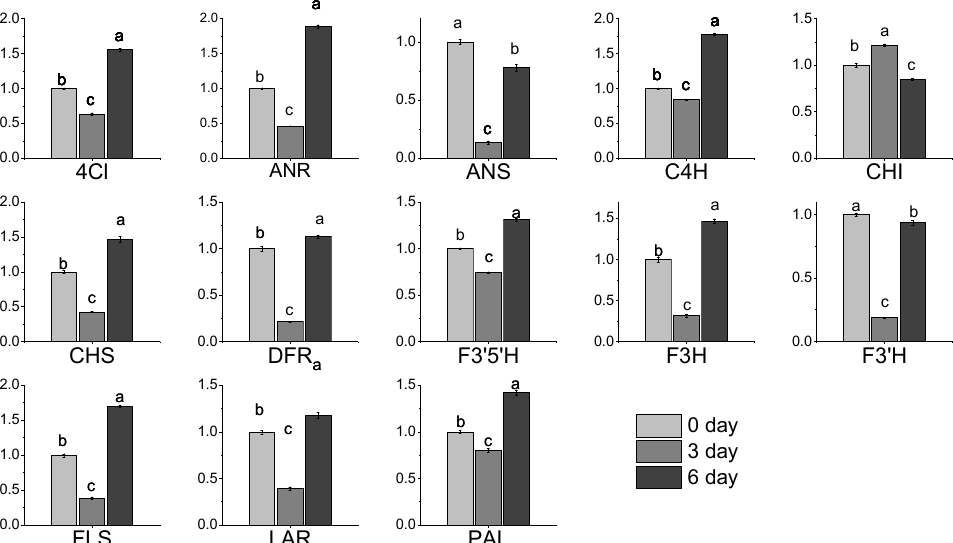
mechanisms (CSS0040654) and response to oxidative stress (CSS0009596 and CSS0019730) were highly connected with other genes.